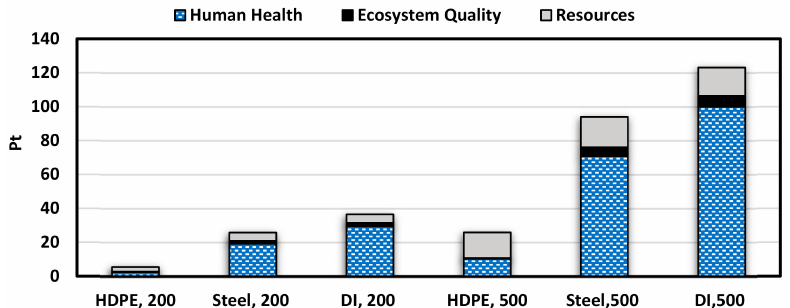
Figure 3. Comparison of the pipes’ impacts in the total phases of production, transportation, and